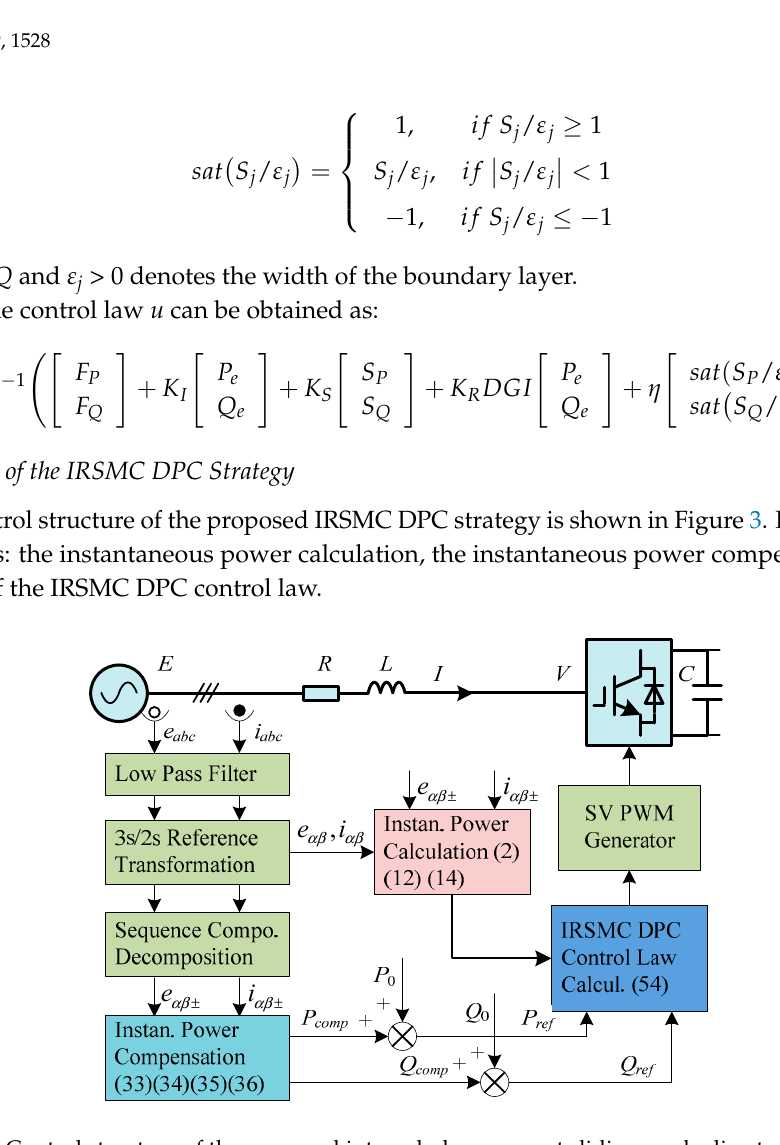
Figure 3. Control structure of the proposed integral plus resonant sliding mode direct power control (IRSMC DPC) strategy.